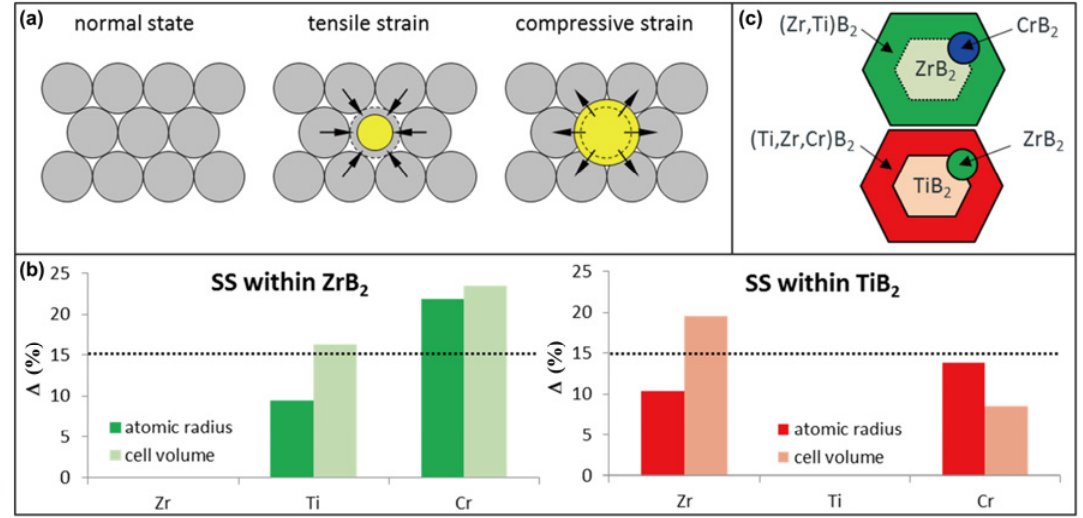
Fig. 11 (a) Local stress in substitutional solid solutions induced in the host cell in the case of incorporation of smaller or larger species (yellow spheres). (b) Plot of the difference amongst Ti, Zr, Cr atomic radius and amongst the corresponding boride cell volume; a value below 15% indicates favourable tendency to form solid solution within ZrB 2 or TiB 2 lattice. (c) Sketch of the ZrB 2 - and TiB 2 -rich grains asset upon